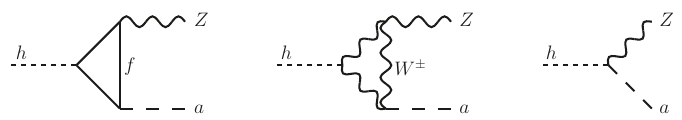
Figure 10 . Feynman diagrams contributing to the decay h